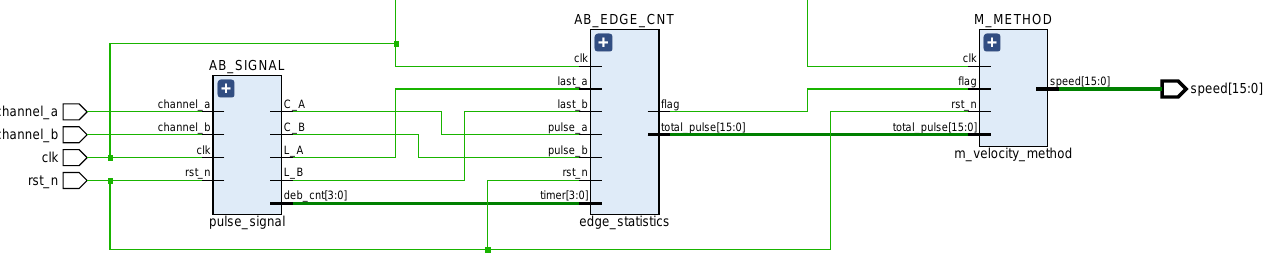
Figure 17. Speed measurement module RTL